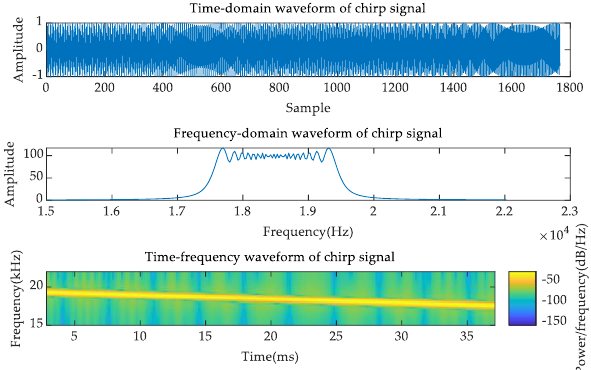
Figure 3. Time domain, frequency domain, and time − frequency characteristic of chirp signal with time duration of 40 ms between 17.5 and 19.5 kHz.